Question: Summarize what this figure shows in one sentence.
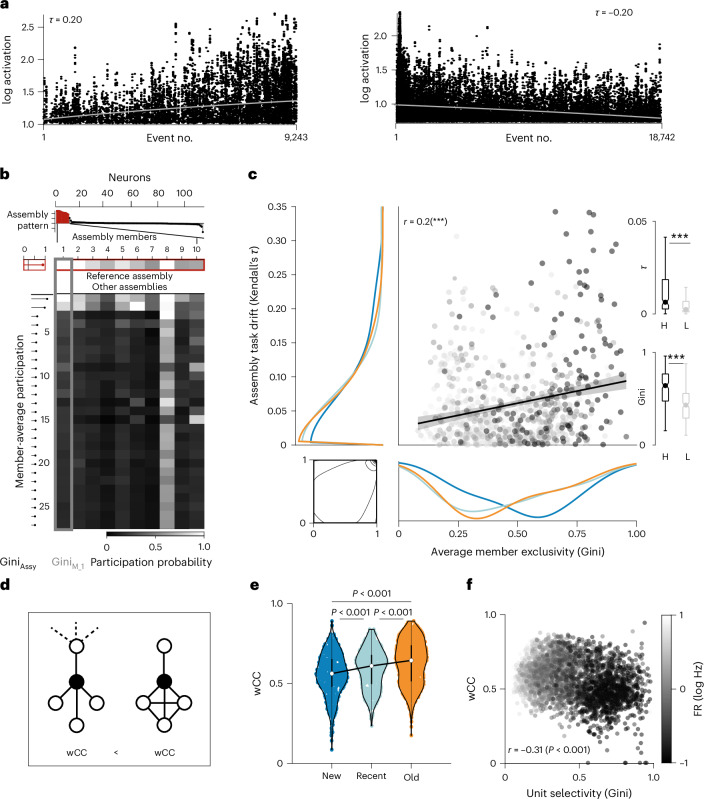
Answer: Network properties of assembly reorganization. a , Examples of drifting cell assemblies with positive and negative drift in activation strength across the task, indicated by white lines representing the Theil–Sen estimator. b , Schematic representation of assembly exclusivity and member selectivity quantification. Top: a reference assembly pattern expanded to show the participation of its members (red box). Below: participation probability matrix depicting the participation probability of each of the reference assembly members (columns) for a given alternate assembly (rows) for all detected cell assemblies within a session. Left: average participation probability of the target members during each detected cell assembly in the session. Higher average member exclusivity of a reference cell assembly is indicated by lower average member participation probabilities across all but the reference cell assembly, measured as the Gini Assy coefficient. A selectivity index was calculated for each member (unit) based on the distribution of participation probabilities across all detected cell assemblies (Gini M_no. ) (see Methods for details). c , Scatterplot showing the relationship between assembly drift during the task (Kendallʼs τ ) and the average exclusivity of assembly members (Gini coefficient), with marginal distributions separated by memory category ( n = 922 assemblies). Points are grayscale coded based on absolute changes in mean correlations from the first 25% to the last 25% of cell assembly activation events in the task (see Methods for details). The line represents the best linear fit with 95% confidence intervals, indicating a significant correlation from a permutation test ( P < 0.001). The best-fitted copula model (Gumbel, θ = 1.20) is used to illustrate extreme joint positive dependencies, suggesting that the relationship is pulled by the most extreme points (exclusive, drifting assemblies). Right: distributions of Kendallʼs τ (top) and average member task par